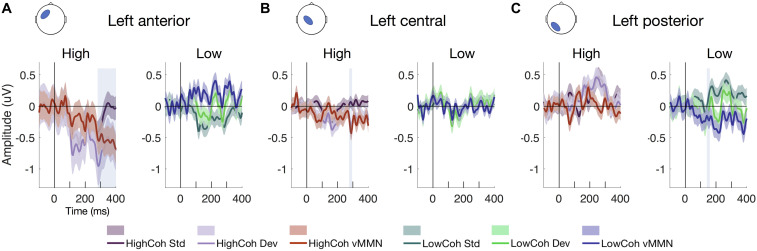
ERP waveforms showing vMMN. Mean ERPs from electrode clusters with significant effects at (A) left anterior, (B) left central and (C) left posterior clusters, showing standard error across participants (N = 19). Left-hand panels show high-coherence ERPs for standard (dark purple), deviant (light purple) and vMMN difference waves (red; deviants – standards). Right-hand panels show low-coherence ERPs for standard (dark green), deviant (light green) and vMMN difference waves (blue; deviants – standards). Significance after FDR correction for multiple comparisons is denoted by the shaded blue boxes.